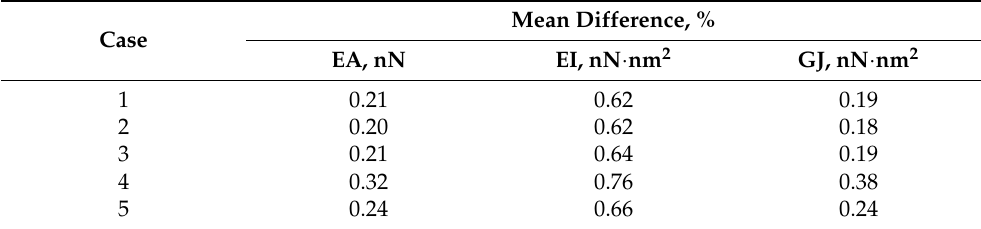
Table 6. The mean difference between the SWBNNTs rigidities values estimated with Equations (26)–(28) and the respective values obtained from FE analysis.